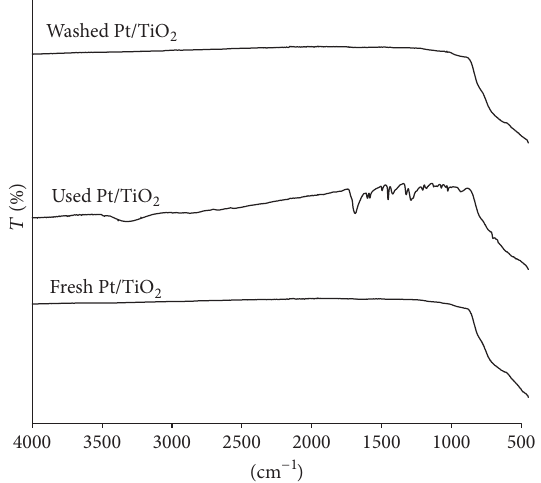
Figure 6: FT-IR spectra of fresh Pt/TiO 2 , used Pt/TiO 2 , and washed Pt/TiO 2